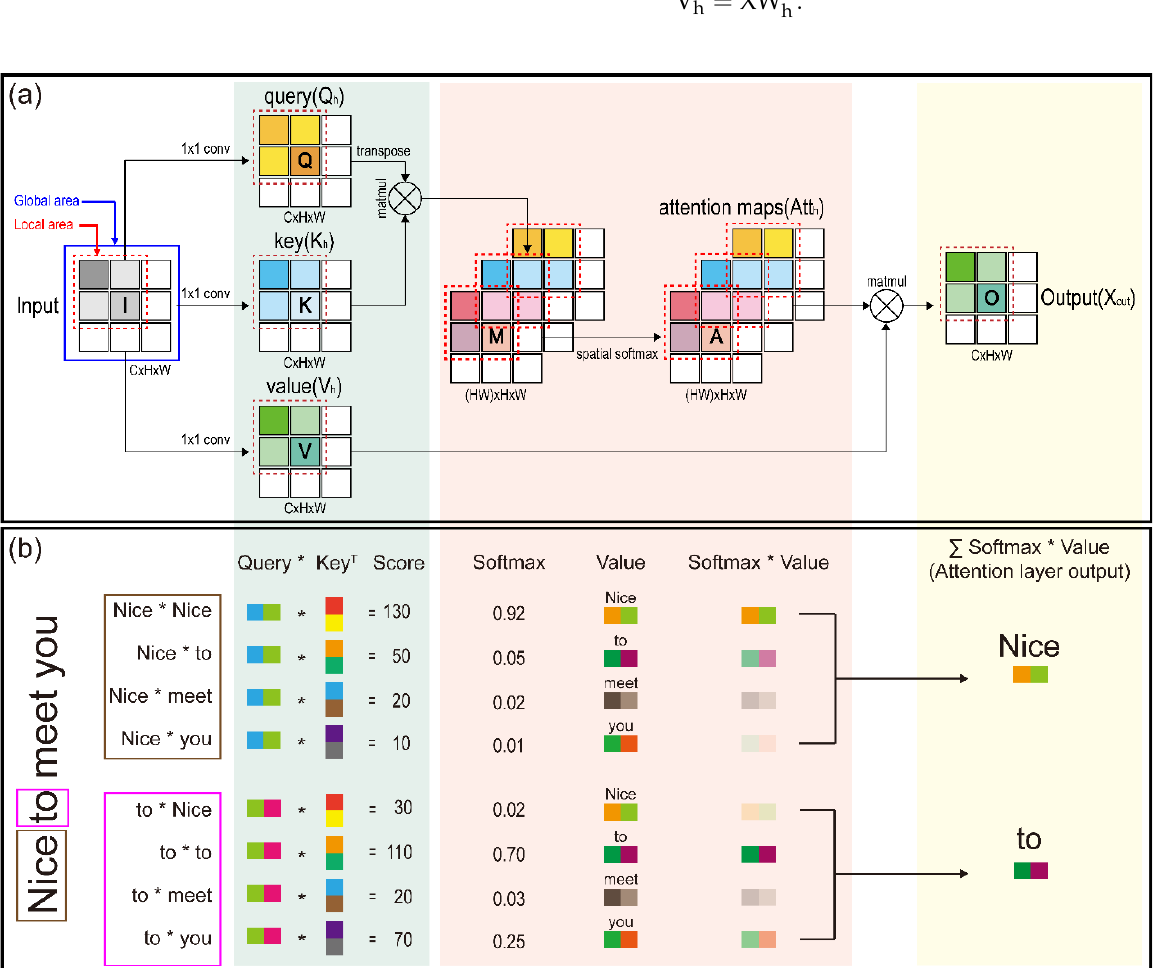
Figure 4. ( a ) Details regarding the global and local self-attention process: the blue line square encloses the global area, and red dotted line square encloses the local area; and ( b ) self-attention mechanism processing process presented for the sentence “Nice to meet you”. (* for dot product).